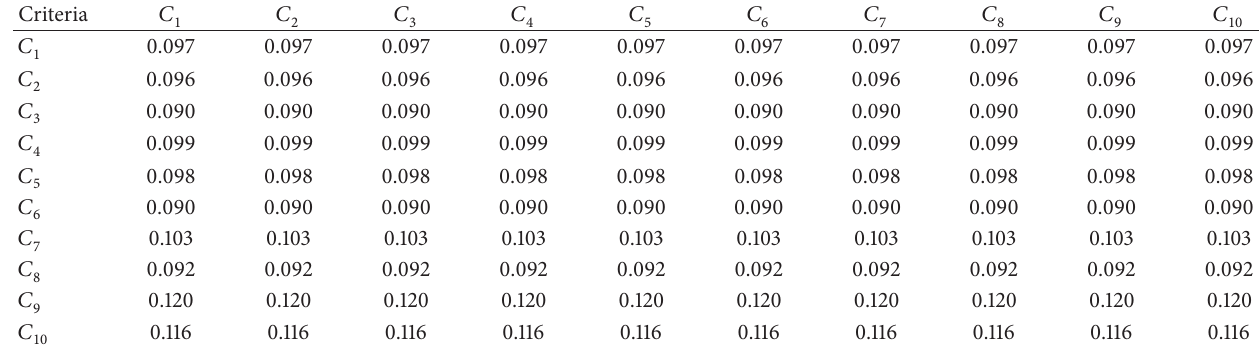
Table 7: The stable matrix of